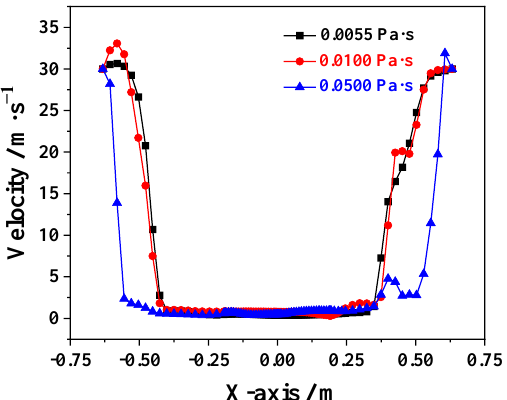
Figure 9. Velocity distribution in the x -axis direction under different liquid viscosities (inlet velocity: 30 m/s, density: 1650 kg/m 3 ).